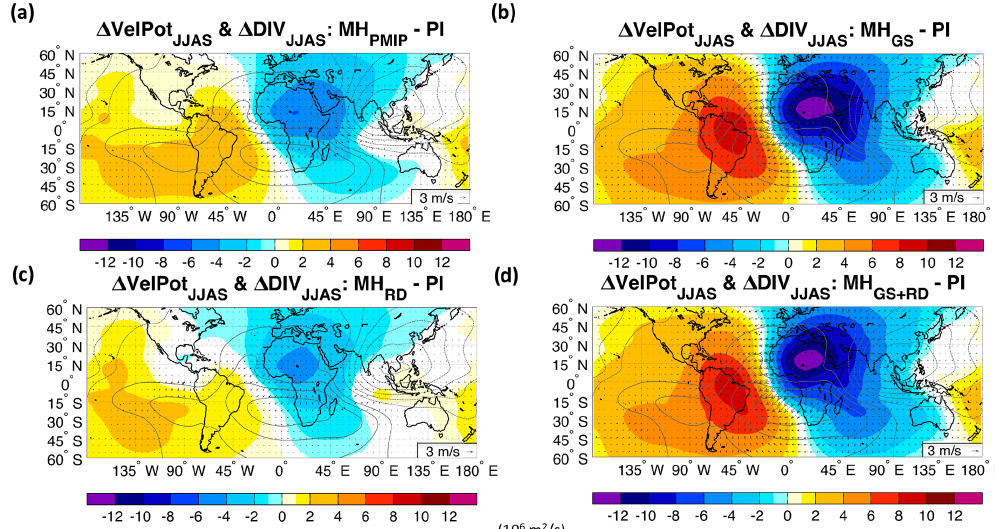
Figure 10. Changes in summer (JJAS) velocity potential (VelPot – shadings; m 2 /s) and divergence wind (DIV – arrows; m/s) at 200hPa for the (a) mid-Holocene-only orbital forcing (MH PMIP ); (b) the Sahara greening (MH GS ); (c) the dust-only reduction (MH RD ); and (d) the Sa- hara greening and dust reduction (MH GS + RD ) experiments relative to the PI reference simulation. The contour lines show the climatological summer velocity potential of the PI experiment. Only differences significant at the 95% confidence level using the Student t test are shaded.